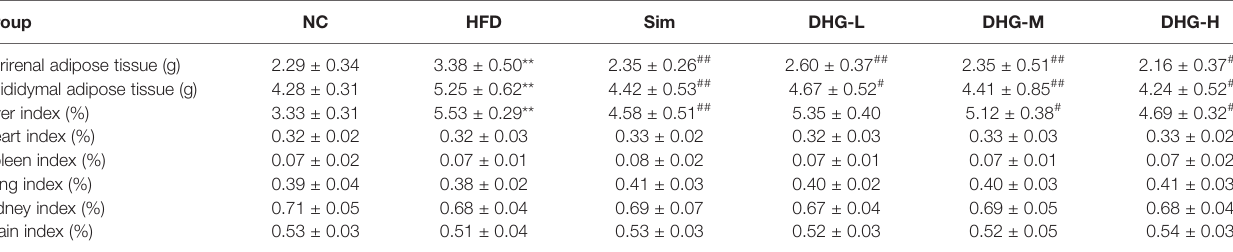
TABLE 2 | Effect of DHG on perirenal and epididymal adipose tissue weight and relative viscera index of hyperlipidemic hamsters. Group NC HFD DHG-H Perirenal adipose tissue (g) Epididymal adipose tissue